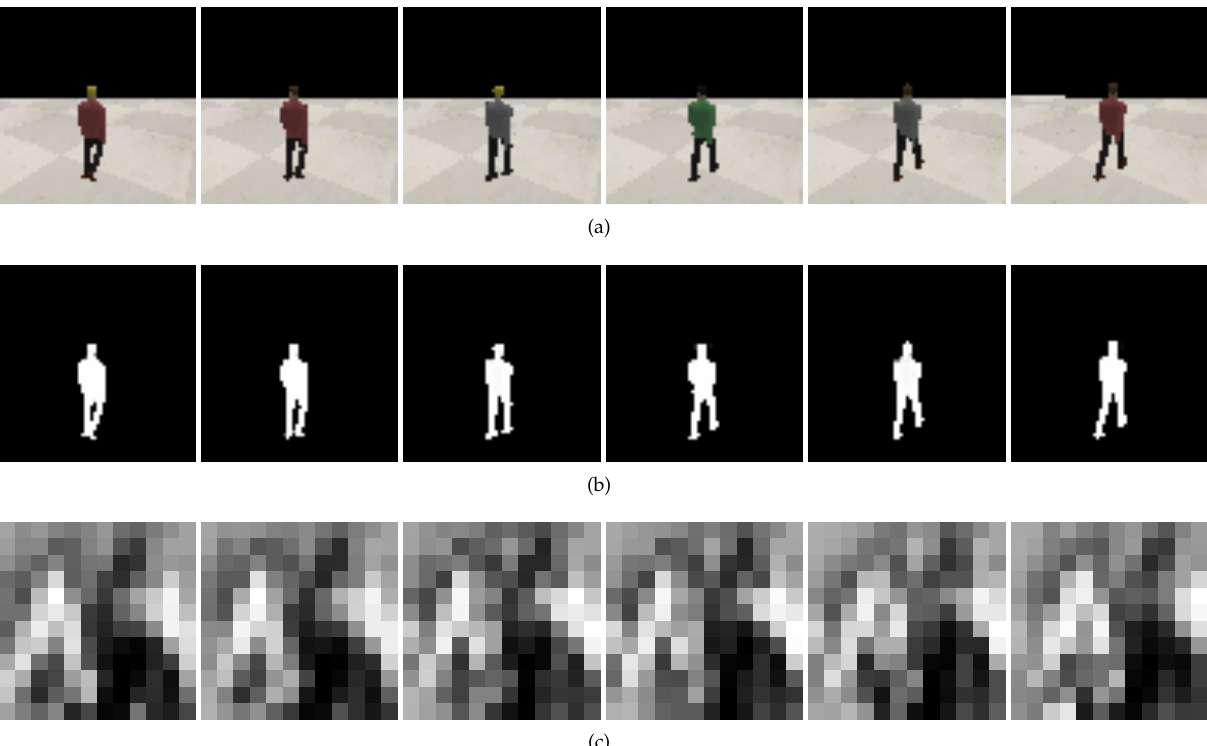
Figure 11. Visualization of the layers and output commands in the RL controller given a sequence of raw observations from timesteps t = 640 to t = 645. ( a ) Sequence of raw observation: O 640 to O 645 . ( b ) The corresponding output of the position perception layer: Z 640 to Z 645 . ( c ) The corresponding output of the velocity perception layer: W 640 to W 645 . ( d ) The final commands of the RL controller ¯ V fb , ¯ V yaw